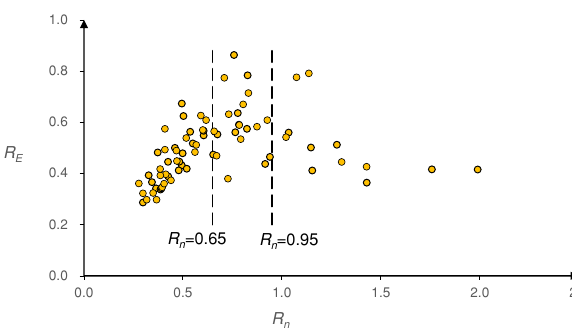
Figure 14. The variation of the kinetic energy coefficient of restitu- tion R E with the normal coefficient R n